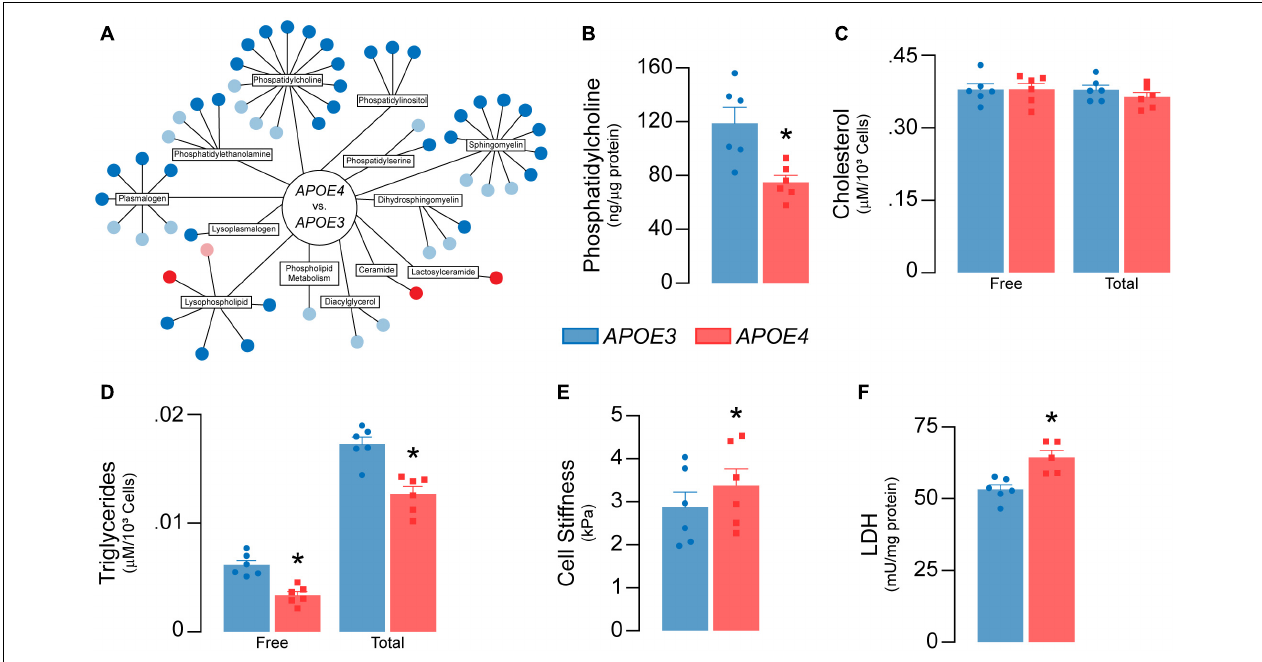
FIGURE 7 | APOE genotype modulates lipid metabolism in brain endothelial cells. (A) Lipidomic analysis reveals 43 significant differences (dark blue = lower; dark red = higher) and 21 trending differences (light blue = lower; pink = higher) in APOE4 brain endothelial cells. Each circle represents a unique metabolite. Most of the metabolites are lower with APOE4 and include phosphatidylcholines (1-myristoyl-2-arachidonyl-GPC (14:0/20:4), phosphatidylethanolamines (1-palmitoyl-2-arachidonyl-GPE (16:0/20:4))), phosphatidylinositols, lysophospholipids (1-oleoyl-GPC (18:1)), and plasmalogens (1-(1-enyl-palmitoyl)-2-arachidonyl-GPC (P16:0/20:4)), with the exception of two ceramides (N-behenoyl-sphingadienine (d18:2/22:0) & actosyl-N-nervonoyl-sphingosine (d18:1/24:1)) that are higher. (B) Consistent with lipidomic analysis, phosphatidylcholine levels are lower with APOE4 when assessed by ELISA. (C) Although there are no differences in cellular cholesterol levels, (D) cellular triglyceride levels are lower in APOE4 brain endothelial cells. (E) Changes in membrane composition can alter mechanical properties of a cell. In the plasma membrane, this can manifest as changes in stiffness, which can contribute to cell stiffness when measured by atomic force microscopy (Askarova et al., 2013). In this technique, a cantilever tip approaches the plasma membrane, makes contact, and then indents the cell surface; the force required to make the indentation corresponds to cell stiffness. We found that cells stiffness is higher in APOE4 brain endothelial cells when measured by atomic force microscopy (analyzed by paired t -test). (F) Lactate dehydrogenase (LDH) is a cytosolic enzyme found in cell culture media when the plasma membrane is damaged, as found with cytotoxicity. Despite the lack of toxicity, levels of lactate dehydrogenase in the media are higher with APOE4 . Data is expressed as mean ± S.E.M. * p < 0.05 by Student’s t -test with n = 6 (unless otherwise specified